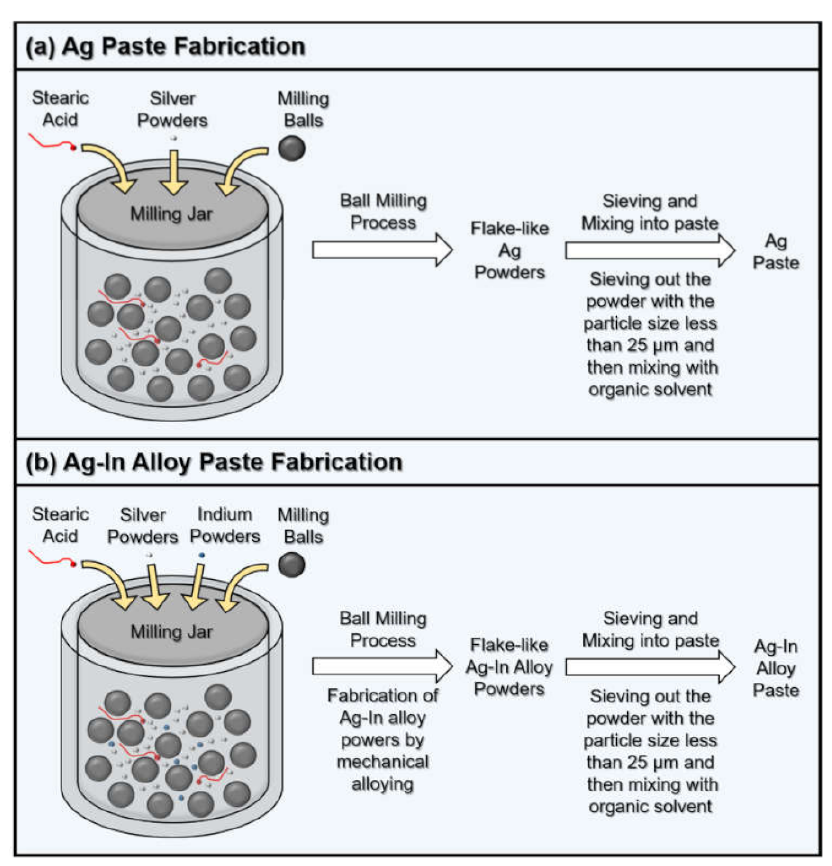
Figure 1. Schematic of the ( a ) Ag and ( b ) Ag–In alloy paste fabrication